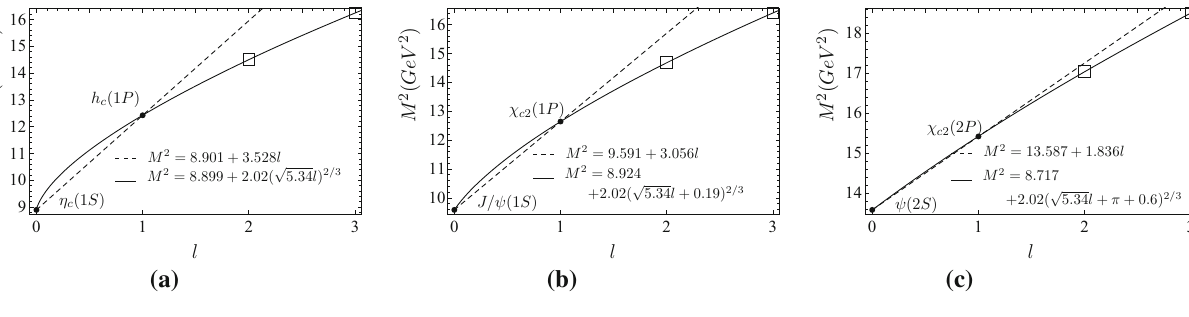
Fig. 7 Same as Fig. 6 except for the orbital Regge